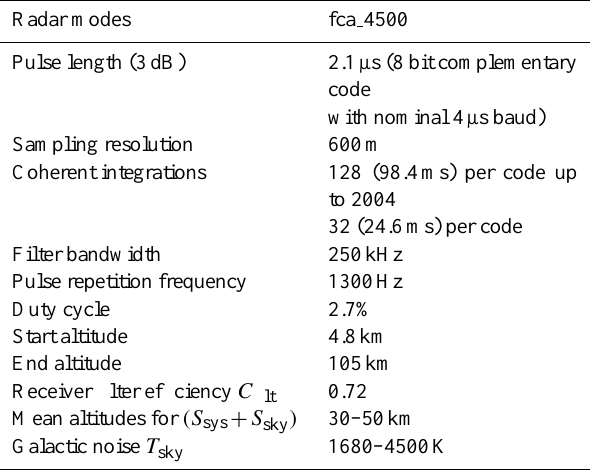
Table 1. Parameters of ESRAD experiment used in this